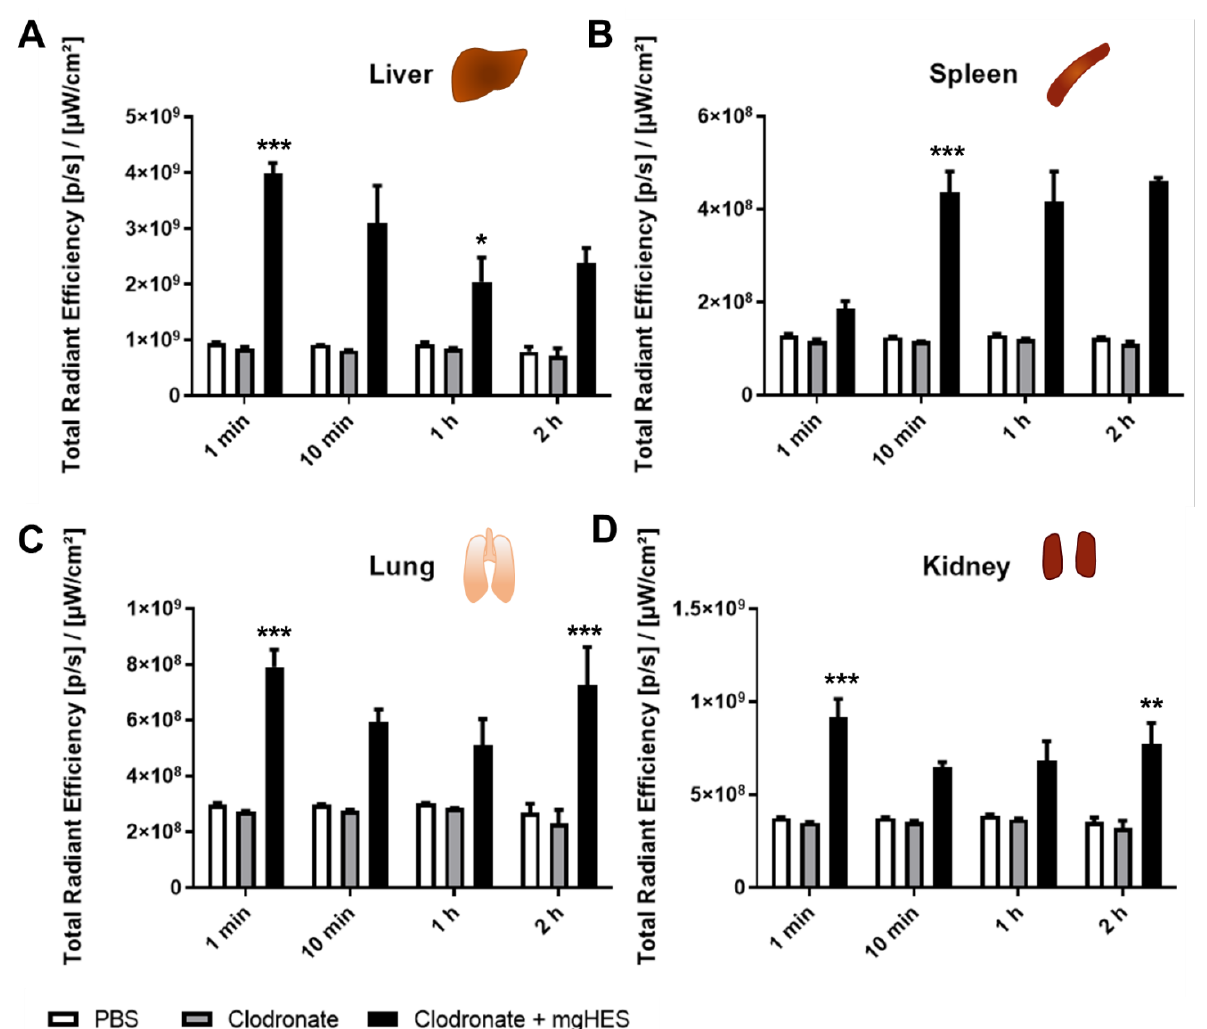
Figure 5. The biodistribution of the mgHES nanoparticles into different organs over time. ( A – D ) Animals were treated with PBS, clodronate-liposomes or mgHES nanoparticles (1 mg). Organs were isolated and imaged with IVIS ® . The fluorescent intensity of all organs was analysed over time 1 min–2 h. ( A ) = Liver, ( B ) = Spleen, ( C ) = Lung, ( D ) = Kidney. For statistical analysis, a two-way ANOVA test was performed comparing PBS versus mgHES nanoparticle treated animals * p < 0.05, ** p < 0.01, *** p < 0.001 (n = 3–5).